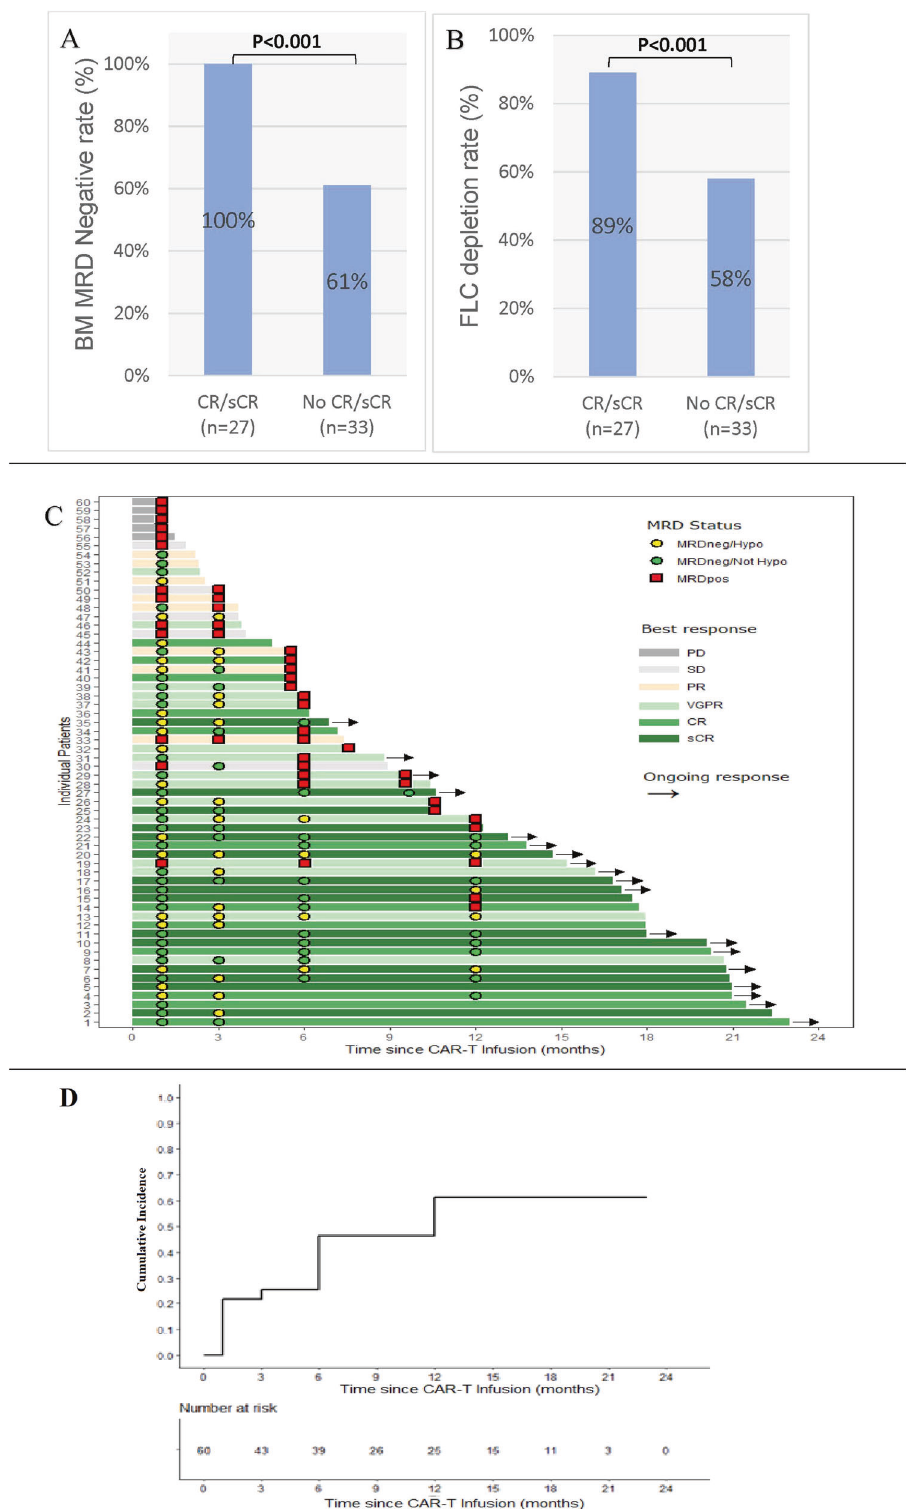
Fig. 1 Bone marrow MRD status and associated clinical outcome for patients with myeloma who received CAR-T. Bar graph comparing rates of BM MRDneg rate ( A ) and FLC clearance ( B ) in patients who achieved CR/sCR (as per IMWG) vs those who didn ’ t. C Swimmer ’ s plot showing progression free survival (PFS) and best response, as per IMWG, among individual CAR-T patients. (Square = MRD positive, Circle = MRD negative), D Cumulative incidence curve for BM MRDpos after CAR-T